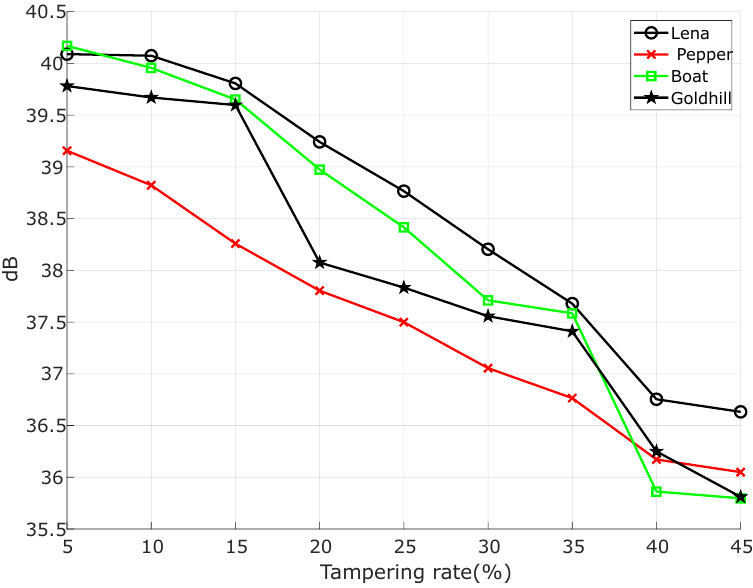
Figure 6. Tampered images at various tampering rates